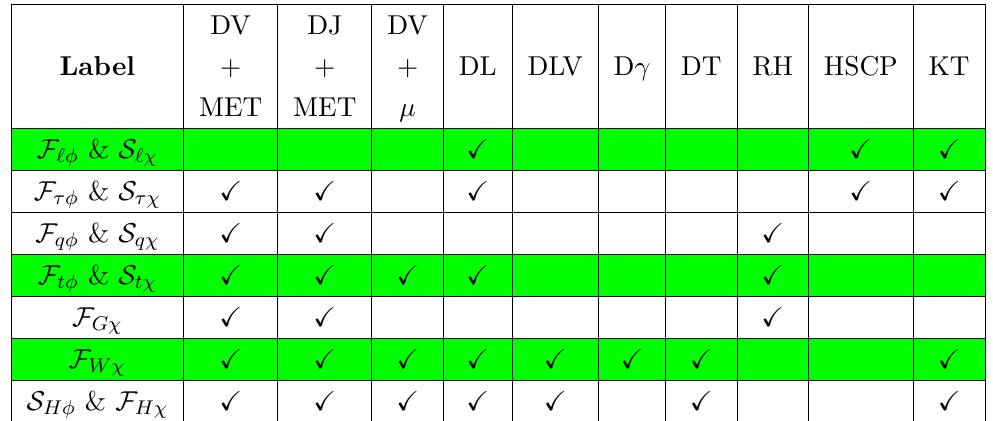
Table 3. Sensitivity of the LHC searches, shown in table 2 and discussed in appendix C, to our simplified models as labeled in table 1. The fermion ψ of table 1 can be either a light lepton SM ‘ ∈ { e, µ } , a tau lepton τ , a light quark q ∈ { u, d, s, c, b } or a top quark t . Fermions can be either left-handed ( L ) or right-handed ( R ), a choice that has little impact on the final state but it can affect LHC production of the mediator Φ Ψ . F and F refer to models of the class F B / B Wχ Gχ Fχ where we consider the SU(2) (coupling to electroweak gauge bosons) and the SU(3) (coupling L c to gluons) field strength, respectively. The models we study in this work belong to the classes highlighted in light